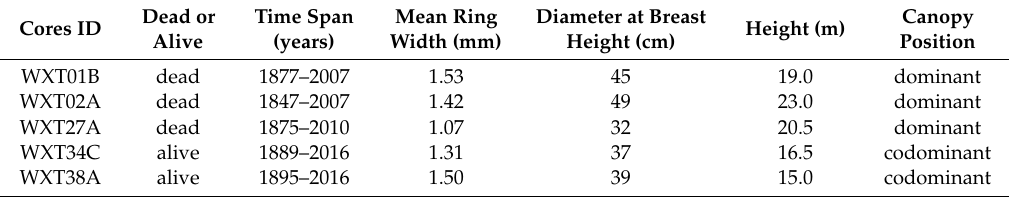
Table 2. Characteristics of the selected dead and live trees used in carbon isotope